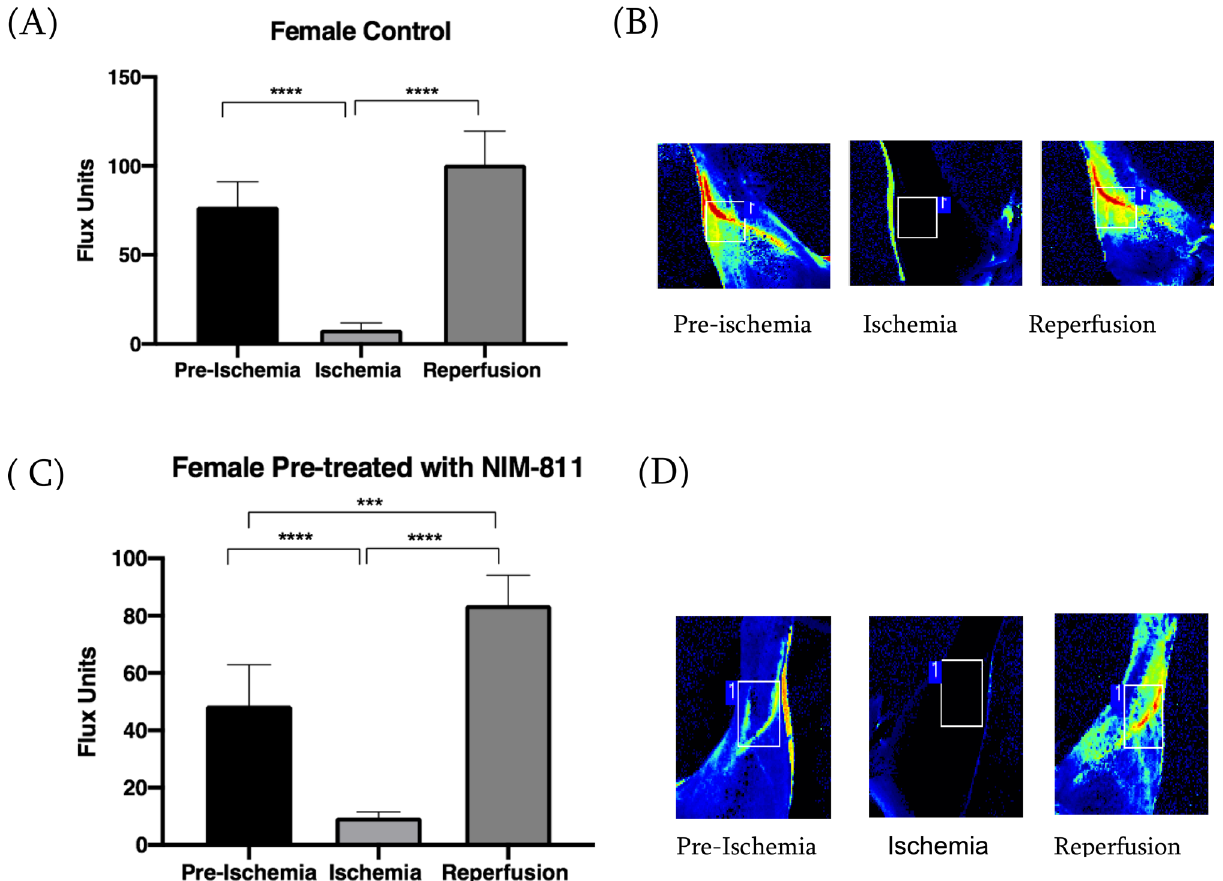
Figure 2. Laser Doppler imaging of female mice models of hindlimb ischemia. ( A ) Blood flow measurements of ischemic left hindlimbs in female vehicle (control)-treated mice subjected to 90 min ischemia the hindlimb baseline (pre-ischemia) flux, as well as the reperfusion flux, were significantly ****P = 0.0001 higher than ischemic flux. ( B ) Representative Laser Doppler images in control mice during baseline, ischemia, and reperfusion. ( C ) Blood flow measurements of ischemic left hindlimbs in female mice treated with NIM- 811 subjected to 90 min ischemia the hindlimb baseline (pre-ischemia) flux as well as the reperfusion flux were significantly ****P = 0.0001 higher than ischemic flux. Moreover, the reperfusion flux was significant ***P = 0.0006 vs. baseline (pre-ischemia). ( D ) Representative Laser Doppler images in female mice treated with NIM-811 during baseline, ischemia, and